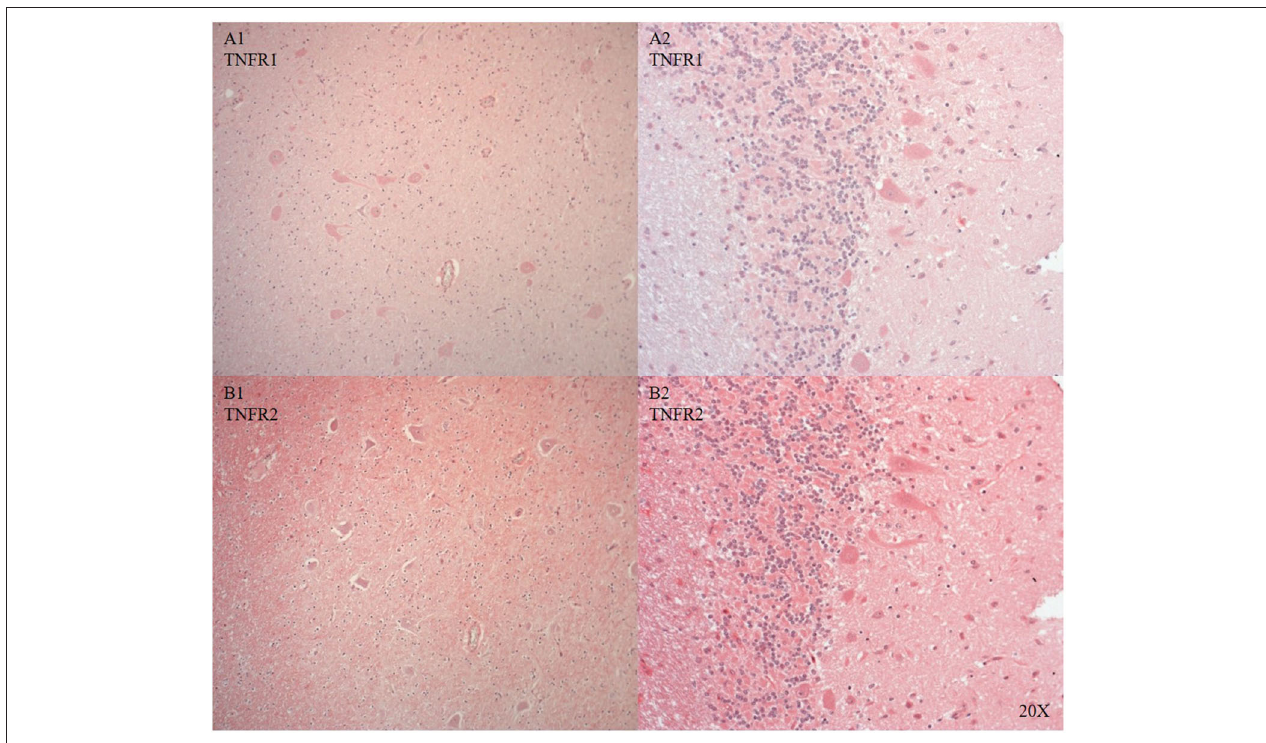
FIGURE 8 | TNFR1 ( A , n = 1) and TNFR2 ( B , n = 1) in the brainstem (A/B 1) and in the cerebellum (A/B 2). In the brainstem TNFR1 (A1) and TNFR2 (B1) were expressed in neurons and microvasculature, and TNFR2 was also expressed in the parenchyma (B) . In the cerebellum purkinje cells expressed TNFR1 (A2) and TNFR2 was expressed in purkinje, granular cells and parenchyma (B2) . TNFR1, anti-tumor necrosis factor receptor 1; TNFR2, tumor necrosis factor receptor